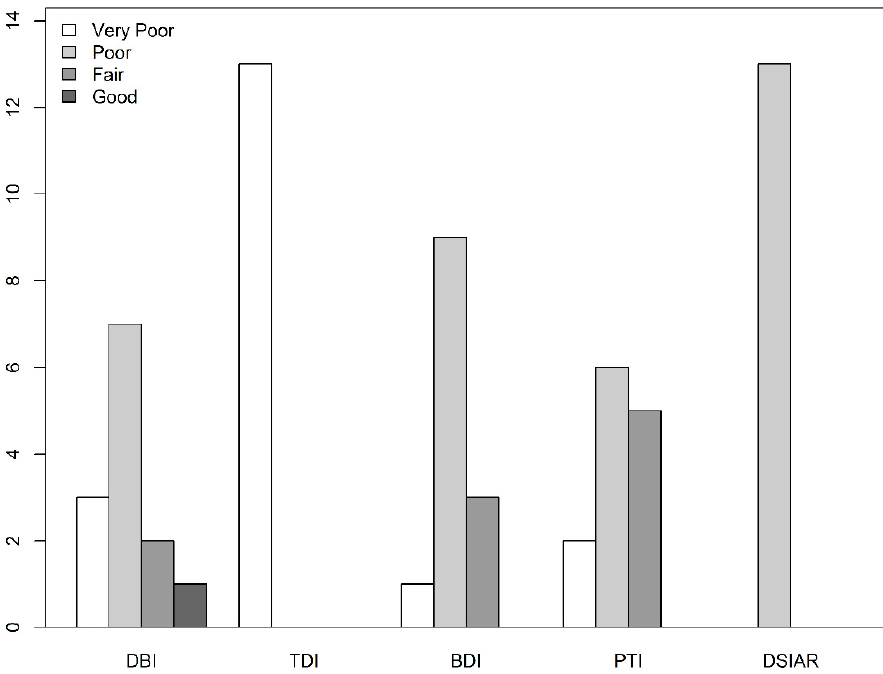
Figure 7. Scores of diatom indexes.